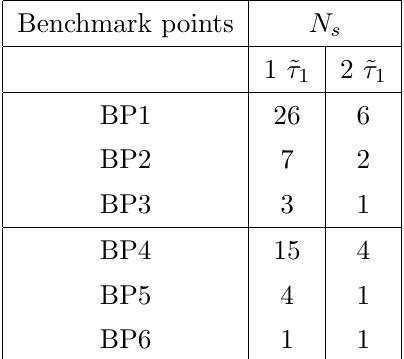
Table 6 . Number of events with 1 ~ (cid:28) 1 and 2 ~ (cid:28) 1 , at an integrated luminosity of